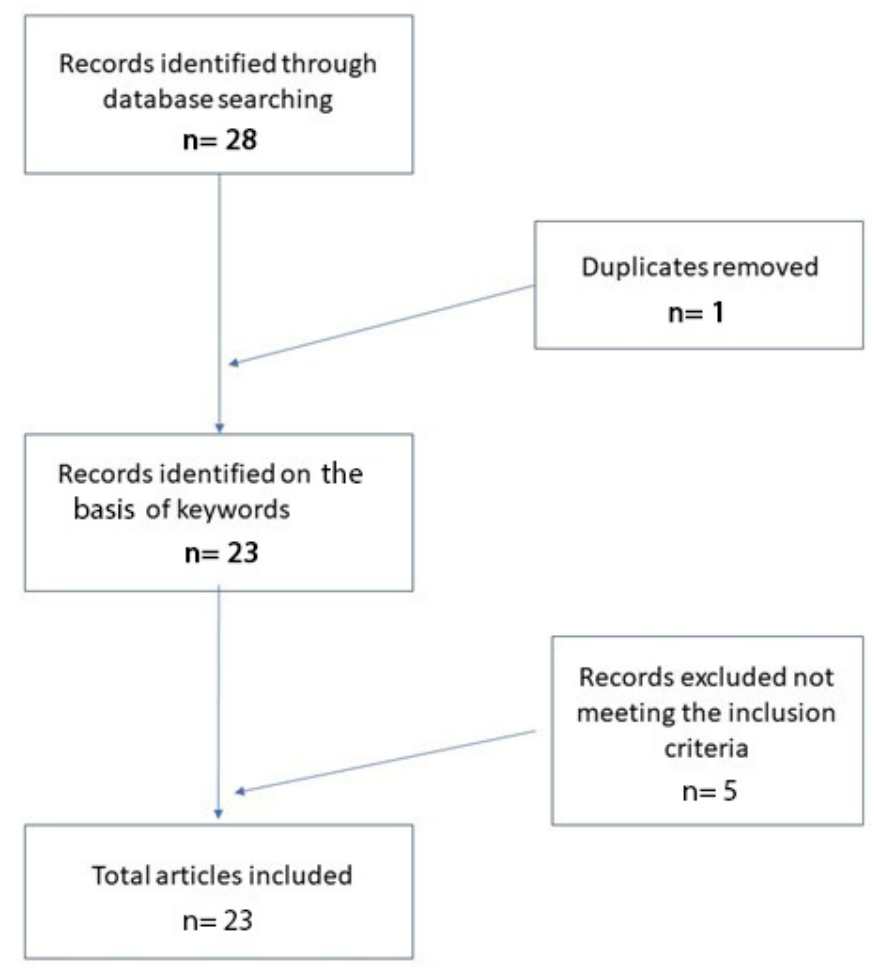
Figure 1. Literature search and article selection.